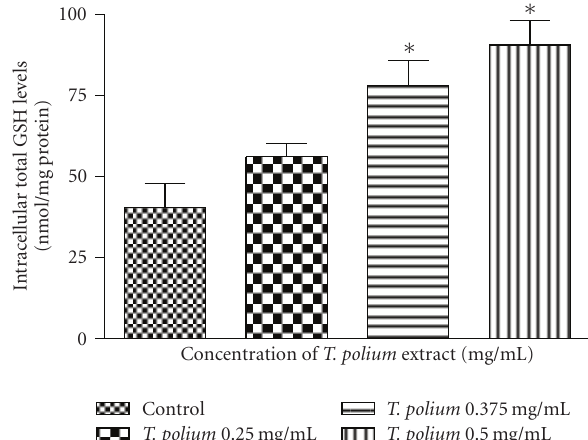
Figure 3: E ff ect of a 24-hour exposure of an aqueous extract of T. polium on total glutathione levels in HepG2 cultured cells. Data are presented as mean ± standard deviation. Sample size ( n ) = 8. ∗ p < 0 . 01 represents the significance of the di ff erence from the